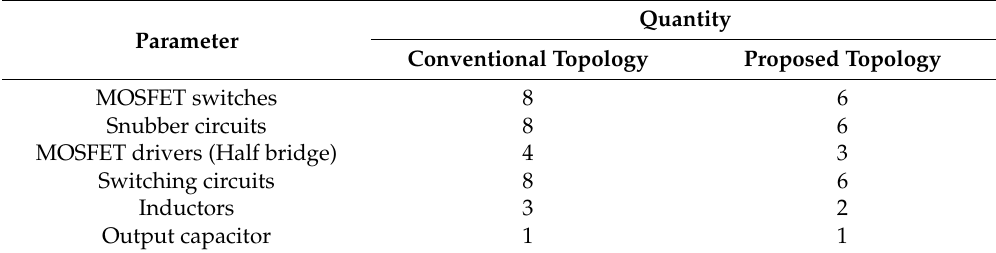
Table 4. Comparison of resource use for the conventional and the proposed hybridisation topology.